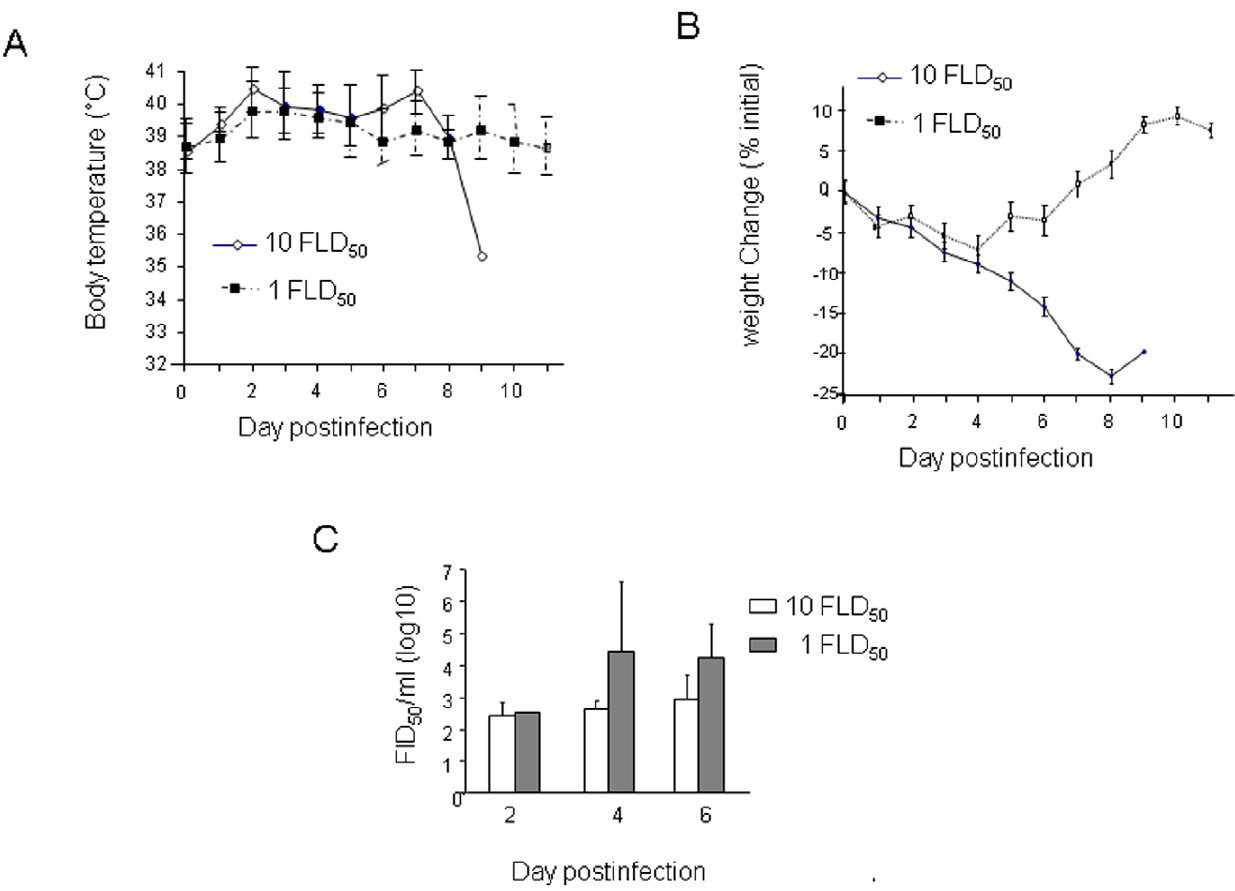
Figure 1. Clinical signs of infection with H5N1 virus A/VN/1203/04 in ferrets. (A) Changes in body temperatures of infected ferrets. Ferrets were inoculated with either 1 FLD 50 or 10 FLD 50 of the viruses, and body temperatures were monitored daily by the use of subcutaneous implantable temperature transponders for 11 days postinfection. Each data point represents the mean value 6 SD for the surviving ferret(s). Note: only one animal remained alive in the 10 FLD 50 group (one value) on Day 9 postinfection. (B). Changes in weights of ferrets infected with the viruses. The weights of ferrets were measured daily. The loss or gain of weight was calculated for each ferret as the percent change in the initial mean starting weight on day 0. Values are the averages 6 SD for the ferret(s) alive for each group. (C) Virus titer in nasal wash with FLD 50 assay. Nasal washes were performed on Day 2, Day 4, and Day 6 postinfection in selection of ferrets in both groups using FLD 50 assay.